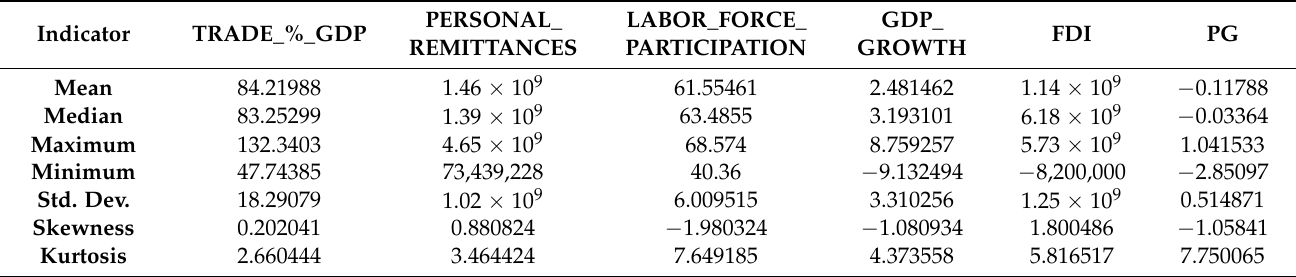
Table 3. Descriptive